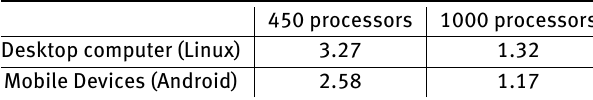
Table 5: Speedup. Local Server with no Redundancy 450 processors 1000